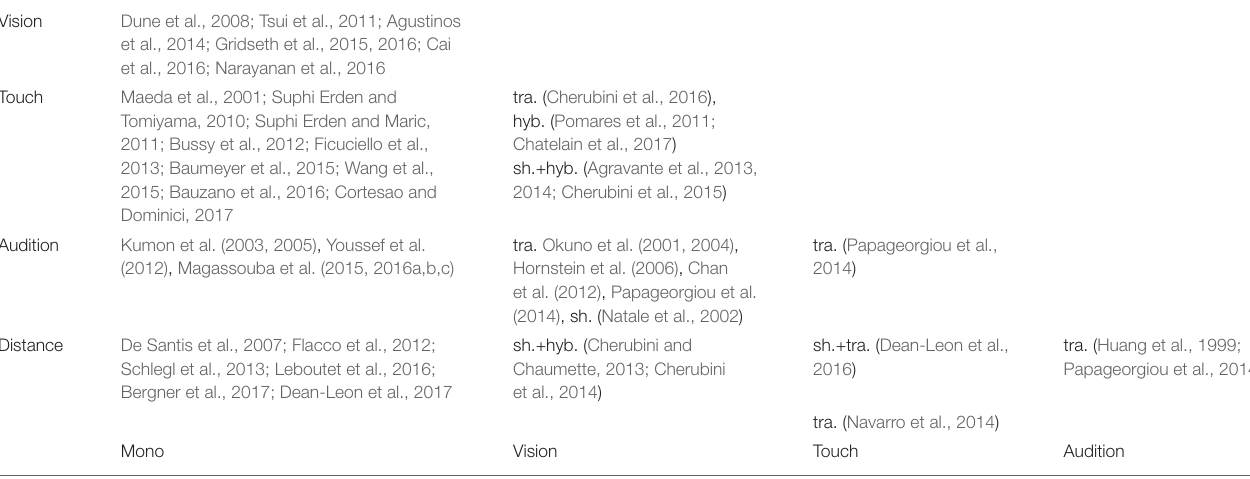
TABLE 2 | Classification based on the sensors. Vision